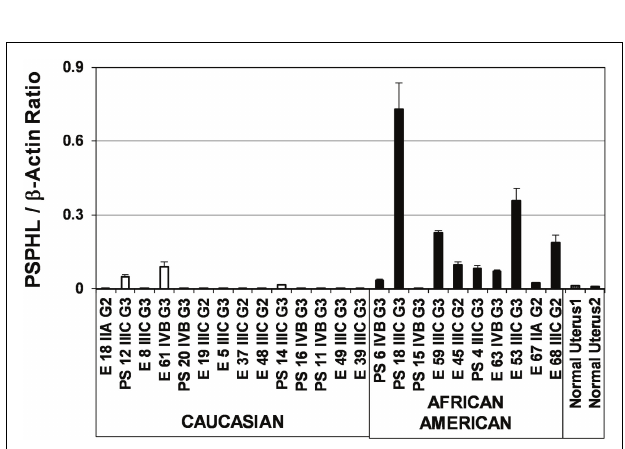
FIGURE 12 | Survival analysis of endometrial cancers using 131 cases (AA-26, CA-105) in which there were I3 (AA-3, CA-10) deaths in the study period of 16years. Top row Kaplan–Meier curves for (A) Race (B) PSPHL, and (C) PSPH. Up and down-regulations are from median level.The p -values